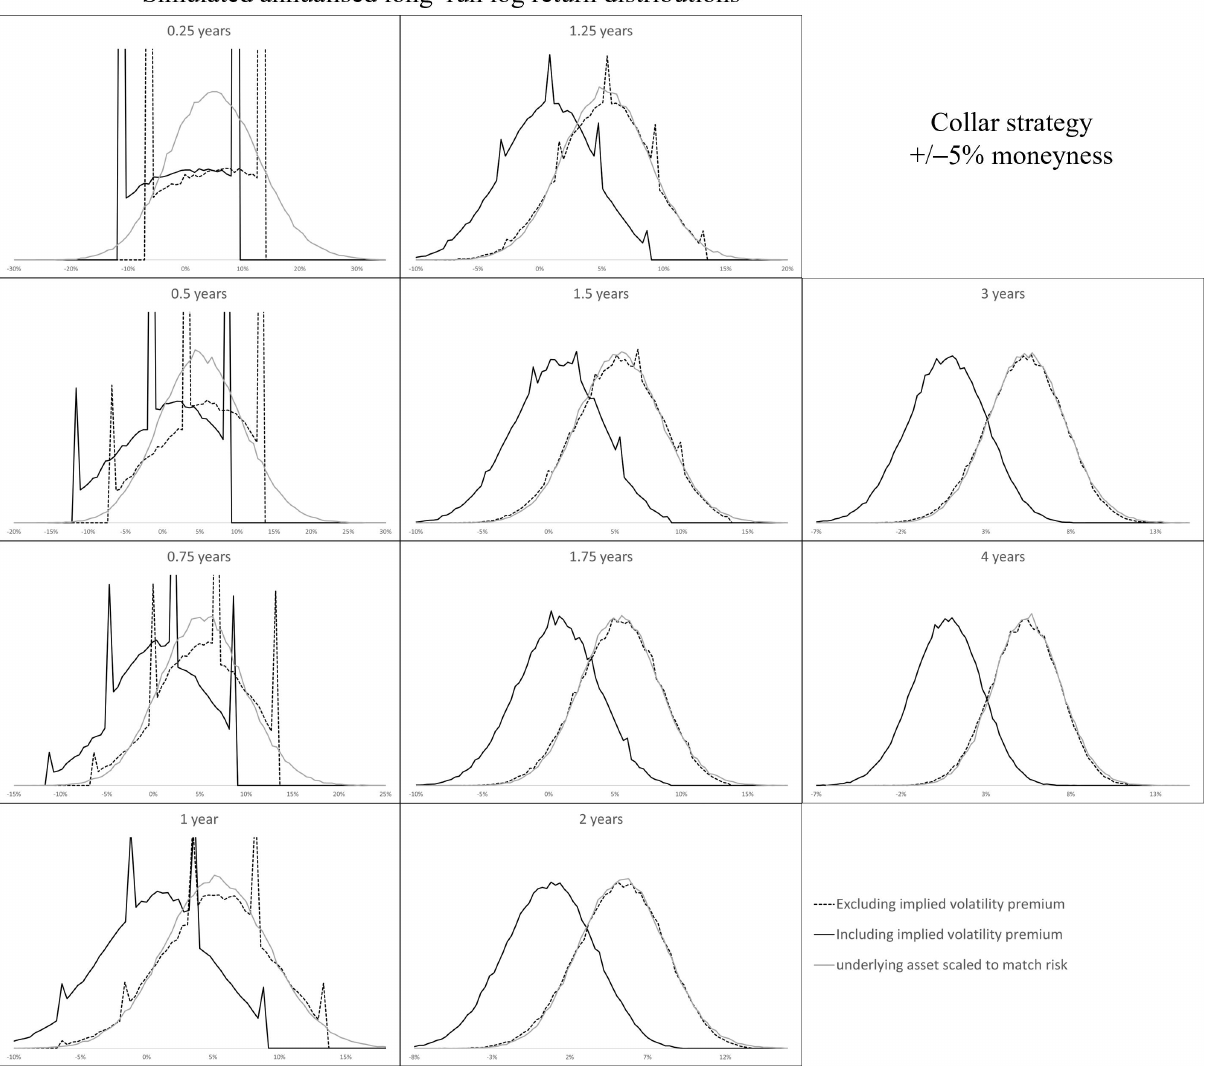
Figure 23. Simulations of the long-run returns of an underlying asset overlaid with a quarterly ± 5% moneyness symmetric collar strategy over investment horizons of 1 / 4 year, 1 / 2 year, 3 / 4 year, 1 year, 1 1 / 4 years, 1 1 / 2 years, 1 3 / 4 years, 2 years, 3 years, and 4 years. The dotted line assumes the